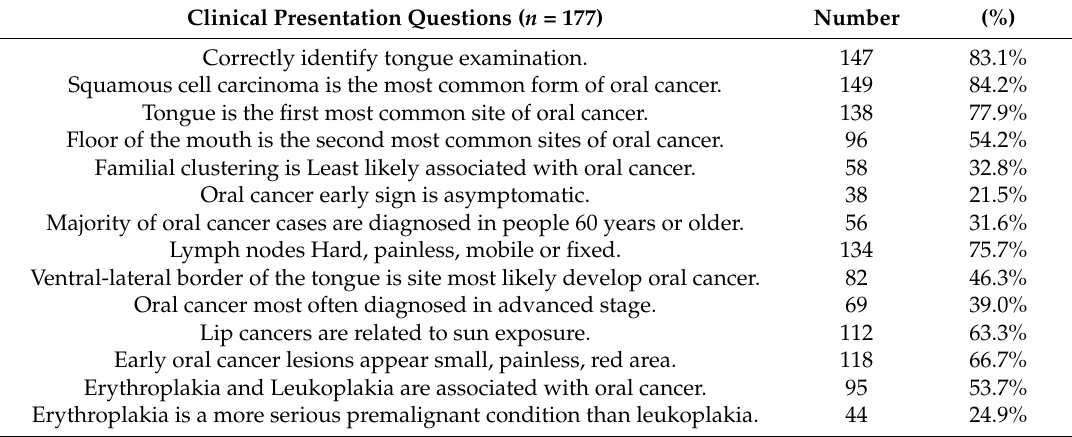
Table 2. Proportion of dentists that correctly identified the clinical presentation of oral